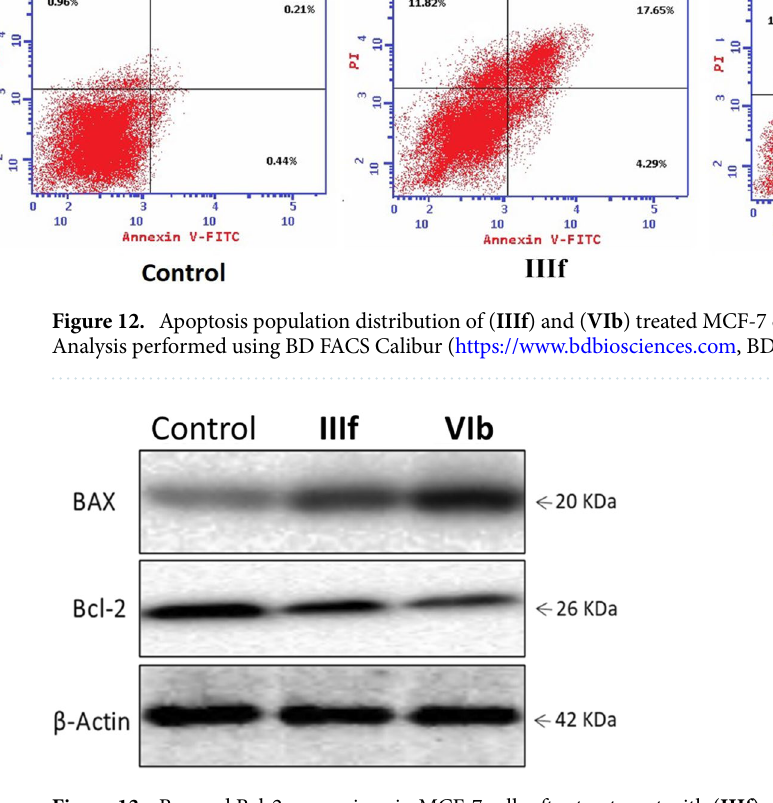
Figure 13. Bax and Bcl-2 expressions in MCF-7 cells after treatment with ( IIIf ) and ( VIb ). Chemiluminescent signals were captured using a CCD camera-based imager (https:// www. bio- rad. com, Chemi Doc imager, Biorad,